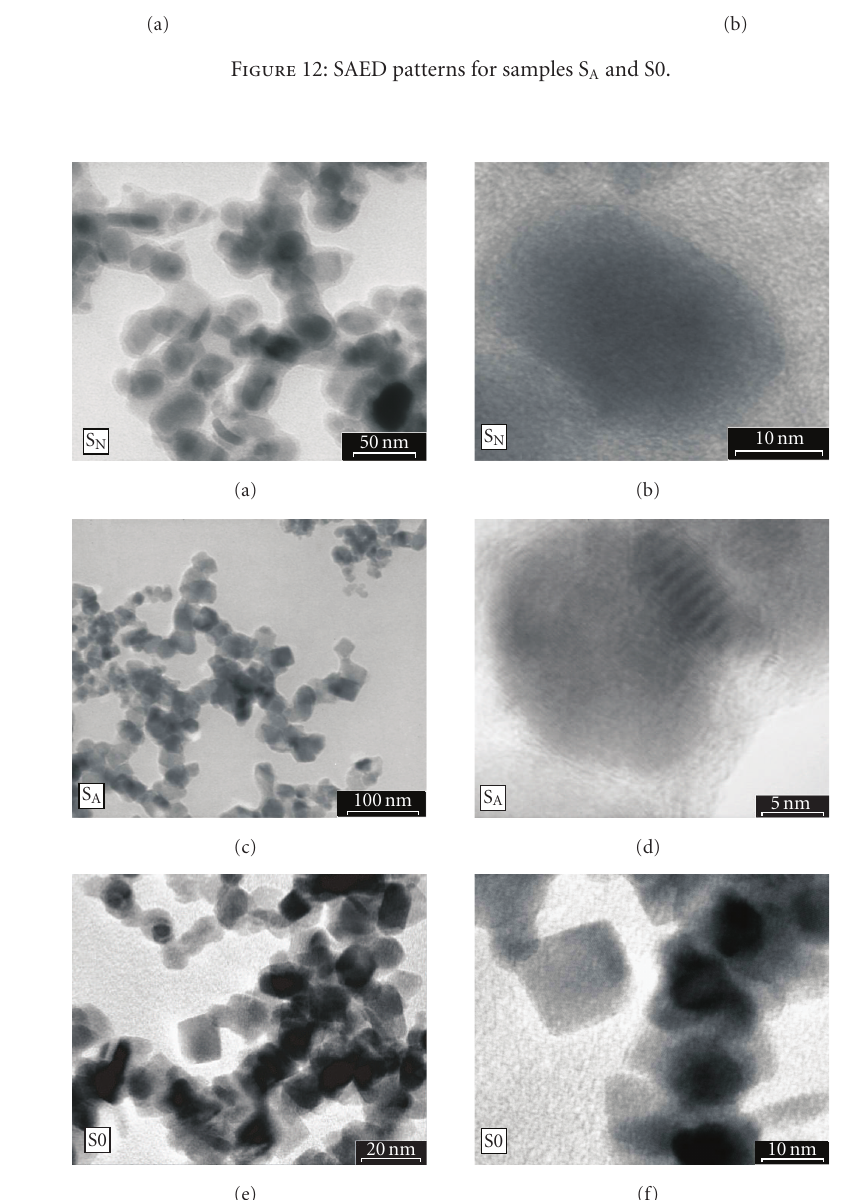
Figure 13: Comparative TEM analysis for medium- (a, c, and e) and high-resolution (b, d, and f) images of titania samples, showing the di ff erent morphologies of S N , S A , and